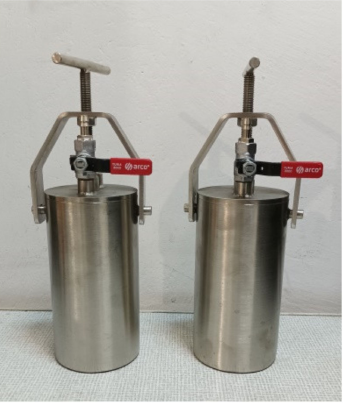
Figure 2. Hermetically sealed containers for coal